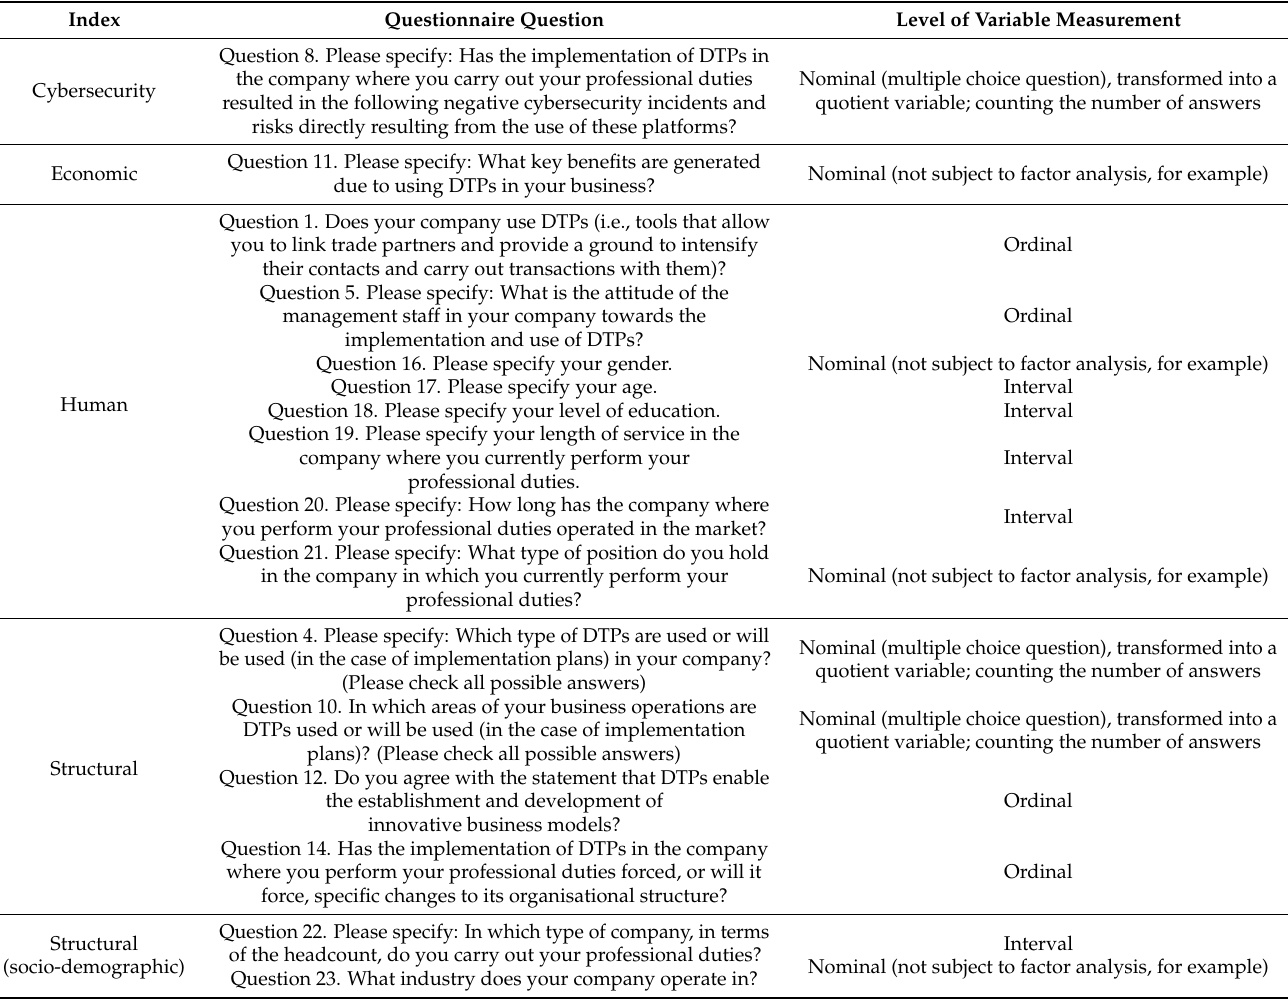
Table 1. Classification of factors of the entrepreneurs’ attitudes towards the digital technology platforms.